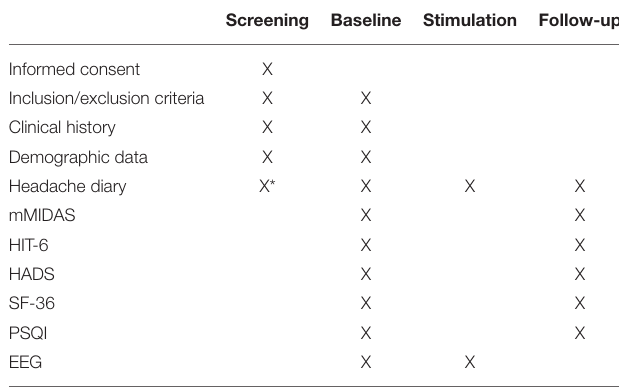
Screening Baseline Stimulation